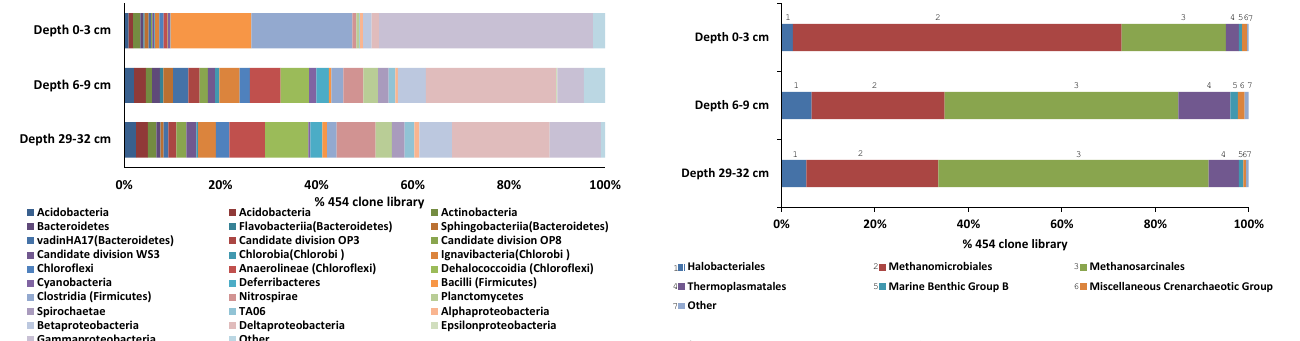
Figure 4. Classification of archaeal sequences using SILVA ngs pipeline. Phyla and order distributions of sequences of the 454 se- quencing above 1% at the different depths in the